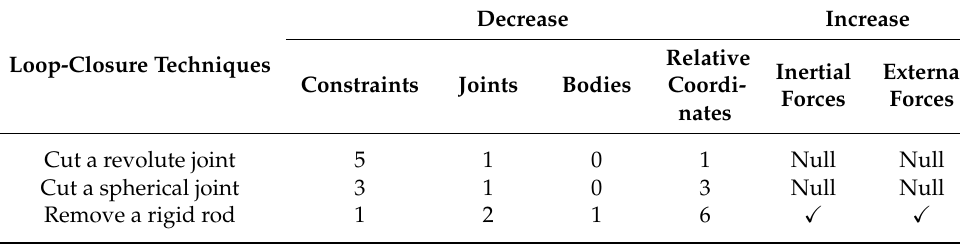
Table 1. Effects of loop-closure techniques on constraints, bodies, and relative coordinates.